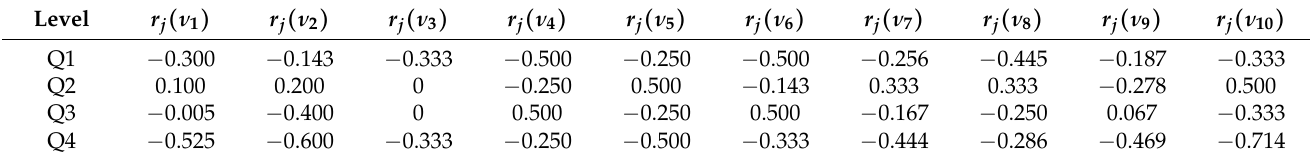
Table 6. Correlation function value of each index to the evaluation level of mine surface subsidence.